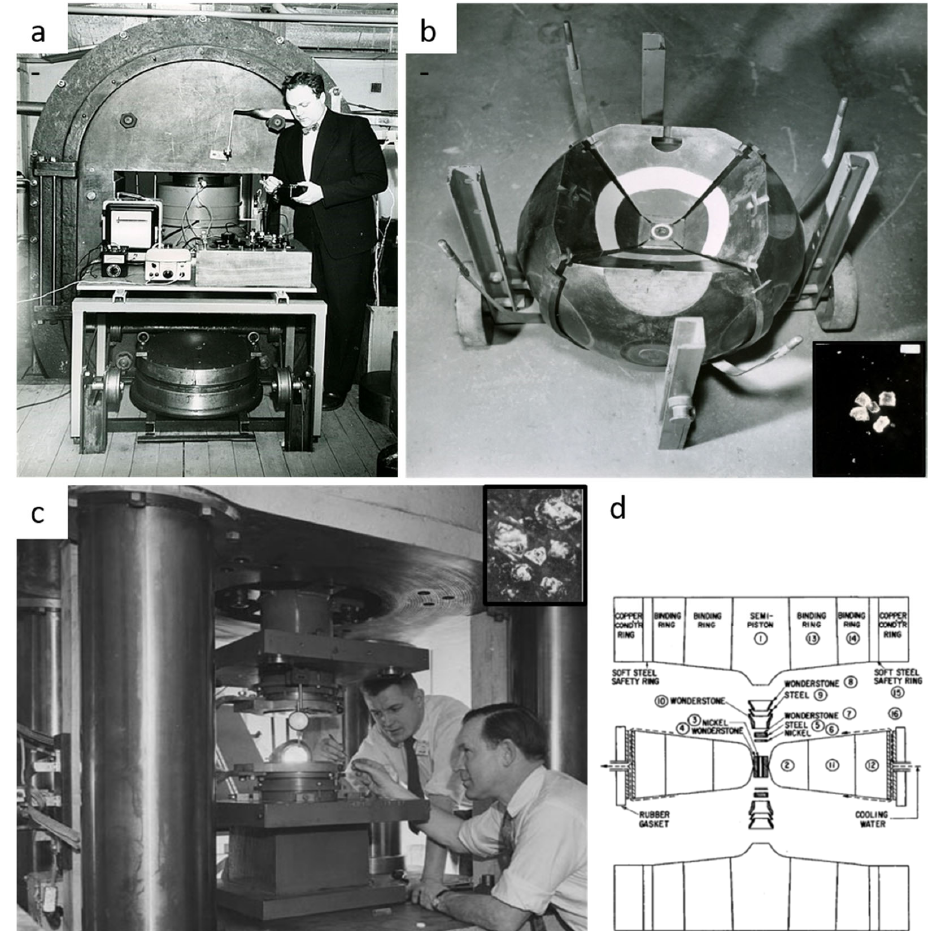
Figure 4. The historical first successful experiments of synthetic diamonds. ( a , b ) From ASAE company (Sweden) using the 6-anvils sphere apparatus [53,54]; a-picture from https://commons. wikimedia.org/wiki/File:ASEA_Quintus_press_for_diamonds_1953.jpg (accessed on 1 December 2021), b-Reproduced from [54], with the permission of AIP Publishing ( c , d ) From GE company in 1955 using the famous Hall “belt”-type apparatus [4,55,56]; pictures from https://www.ge.com/ news/reports/diamonds-werent-forever-in-the-ge-store-but (accessed on 1 December 2021). Inset are shown the recovered diamond after experiments with a typical size of few hundred